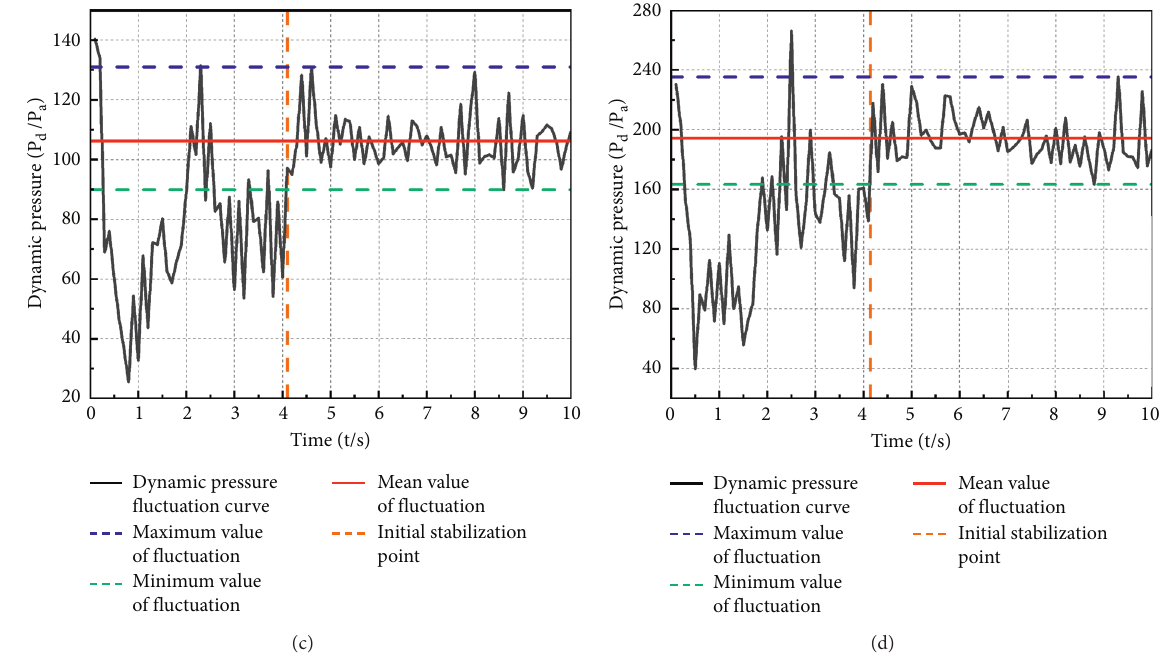
Figure 9: Dynamic pressure curve of sensor head end with flap angle at 10 ° . (a) 50,000m 3 . (b) 100,000m 3 . (c) 150,000 m 3 . (d) 200,000 m 3